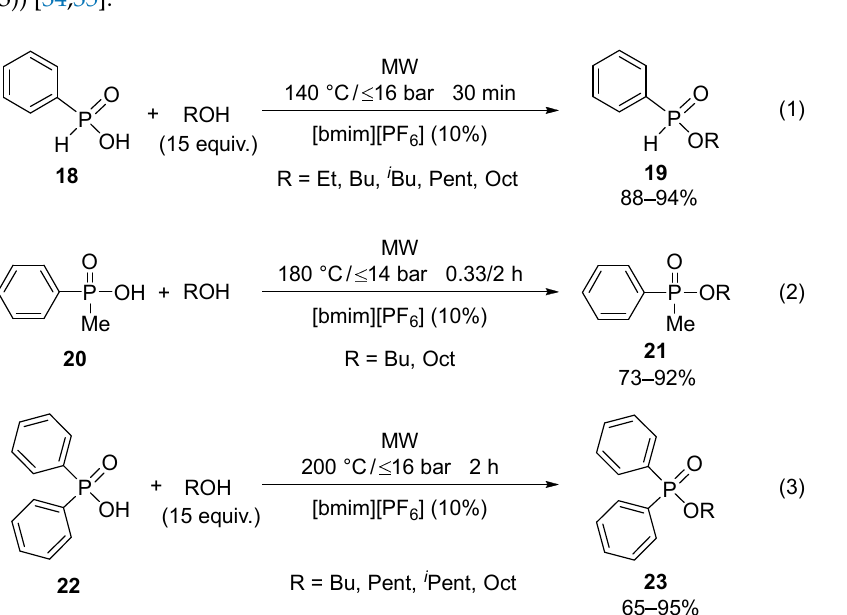
Table 3. MW ‐ promoted direct esterification of phenylphosphonic acid ( 26 ).